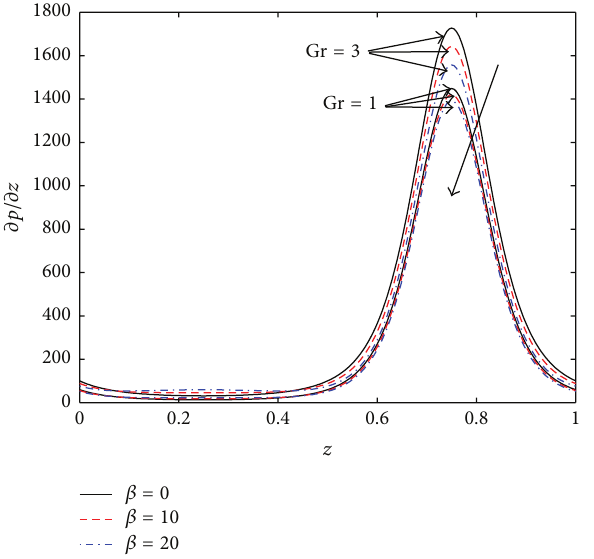
Figure 6: Pressure rise Δ𝑝 versus the time-averaged flow rate 𝑄 for different values of the relaxation time 𝜆 1 and radius ratio 𝜀 with Gr = = 0.4 , 𝛽 = 10 , 𝜙 = 0.4 , and 𝑡 = 1 3 , 𝛼 1